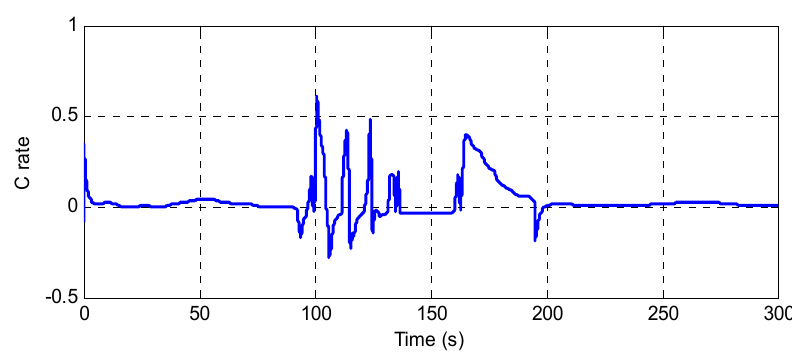
Figure 17. C rate of battery for Case 2.